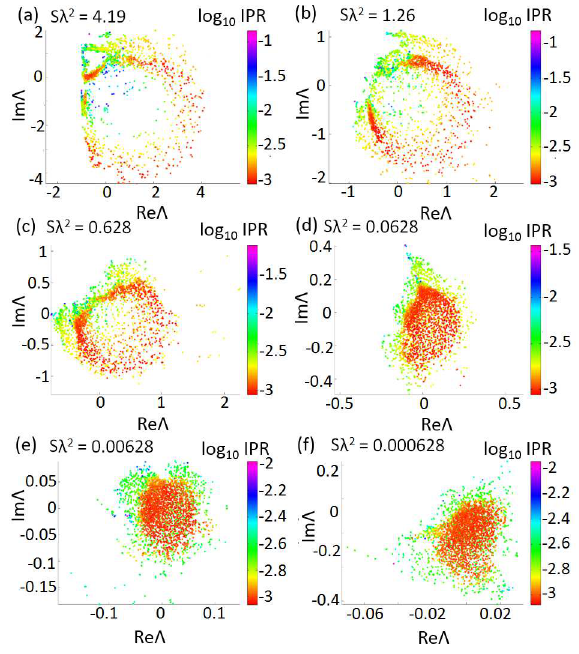
Figure 8. Eigenvalue distributions of the dyadic Green’s matrix in the complex plane for N = 1108 Penrose array with ( a ) S λ 2 = 4.19; ( b ) S λ 2 = 1.26; ( c ) S λ 2 = 0.628; ( d ) S λ 2 = 0.0628; ( e ) S λ 2 = 0.00628; ( f ) S λ 2 = 0.000628. The color bar shows the inverse participation ratio (IPR) of the eigenmode associated to each eigenvalue in log scale.